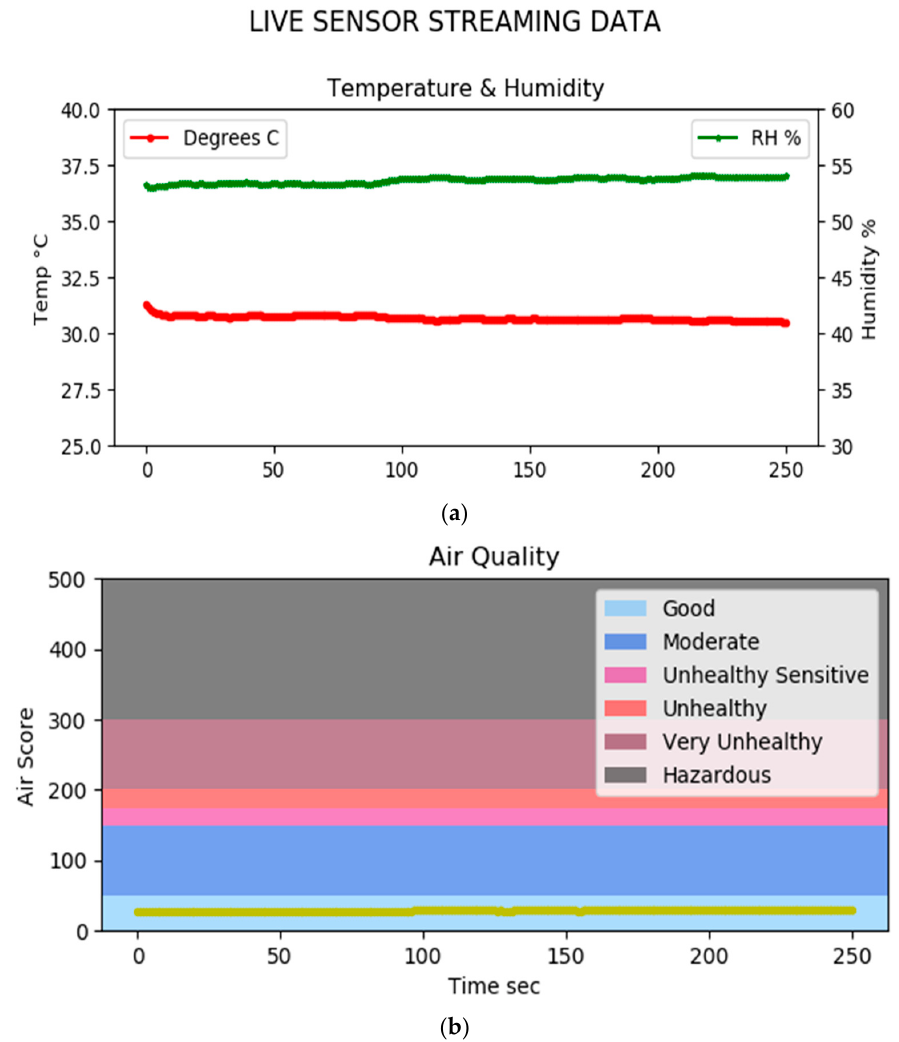
Figure 7. IAQ BME Serial Output: ( a ) temperature in °C and humidity percentage versus seconds. ( b ) IAQ index (VOCs concentrations) and related “wellness” bands.